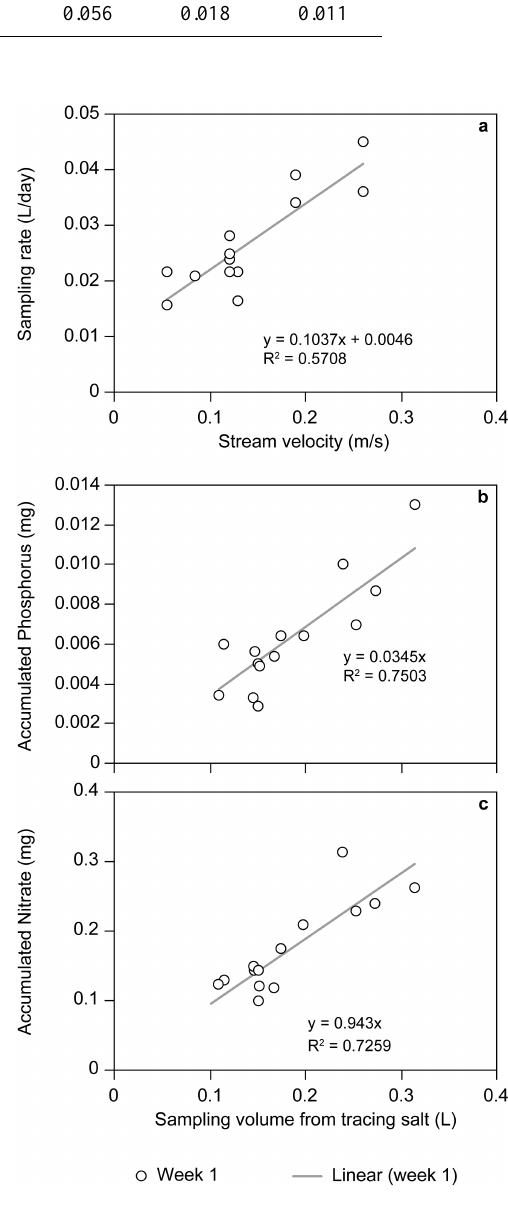
Figure 2. Relationships between (a) stream flow velocity in the flumes and sampling rate of the passive samplers, (b) between dis- solved tracer salt and accumulated phosphorus in the passive sam- plers, and (c) between dissolved tracer salt and accumulated nitrate in the passive samplers. The passive samplers were installed for 1 week in the